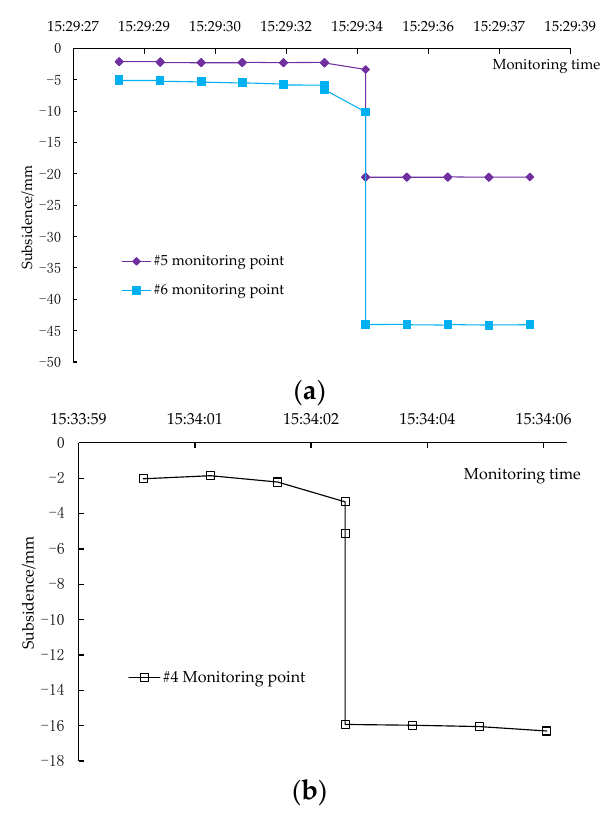
Figure 7. Subsidence of the monitoring points due to mining. ( a ) subsidence of the monitoring points 5 and 6; ( b ) subsidence of monitoring point